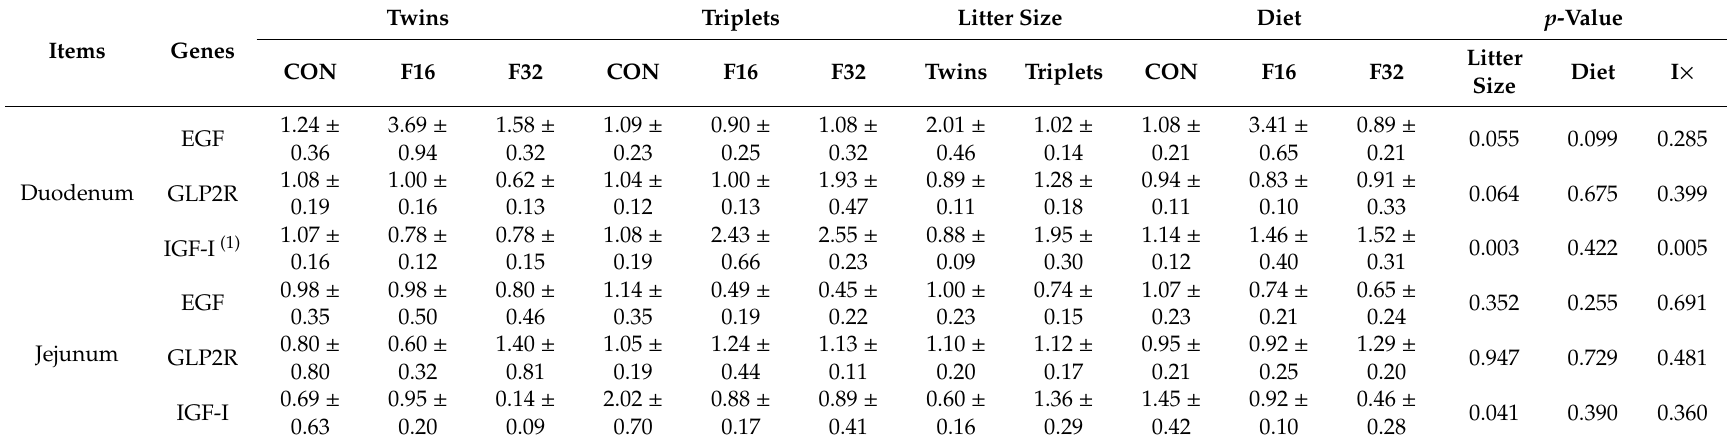
Table 4. E ff ect of dietary folic acid supplementation during gestation on small intestinal development-related genes expression of newborn